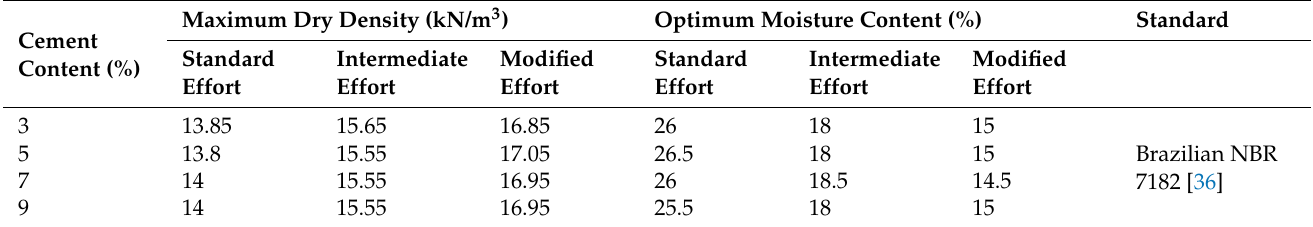
Table 6. Molding condition for yellow silt–cement